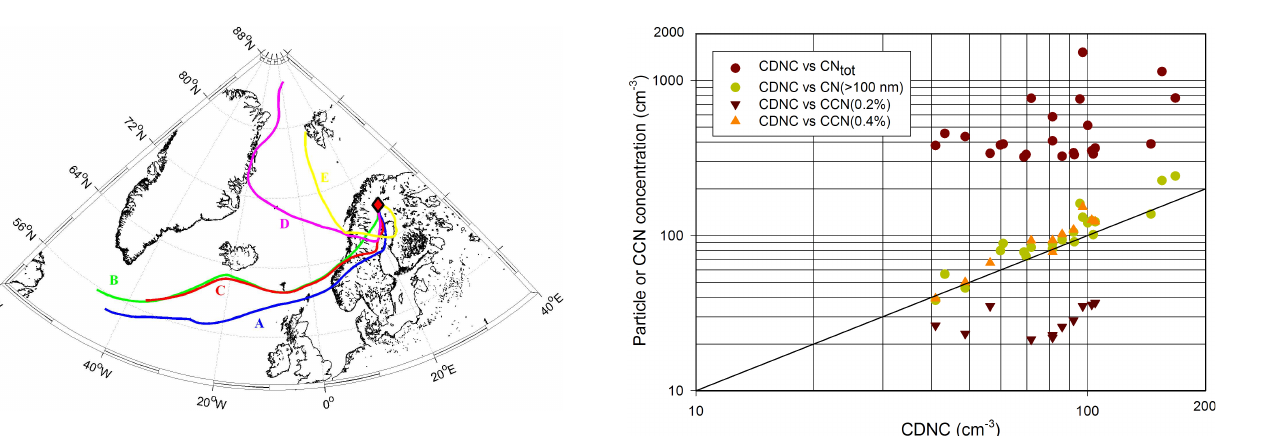
Fig. 1. 72-h back trajectories for each analyzed cloud event (indi- cated in the figure).